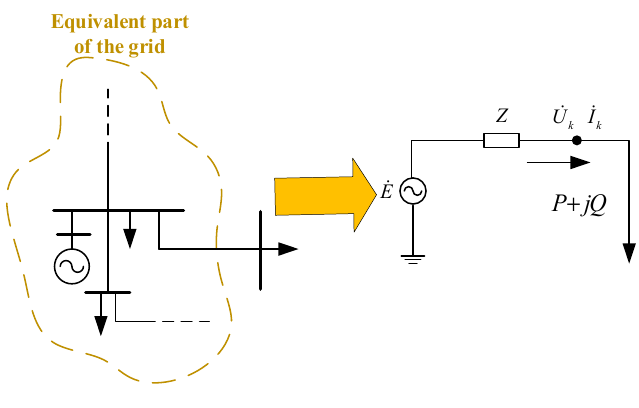
Figure 1. TE circuit observed from load node.